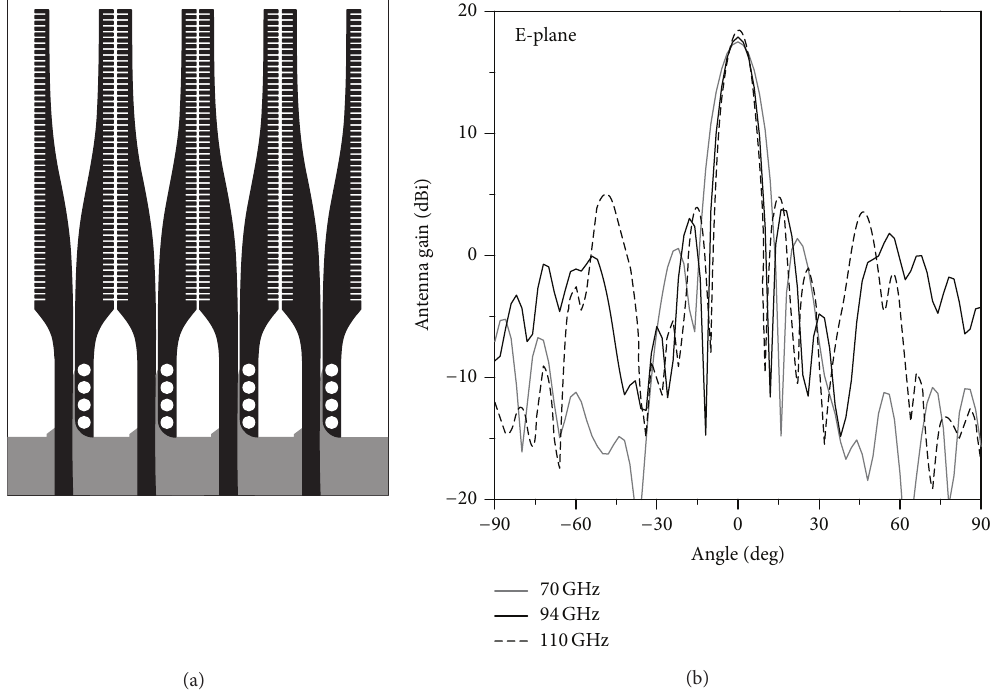
Figure 7: Four-element antenna array (a) geometry, (b) simulated E-plane radiation patterns at 70, 94, and